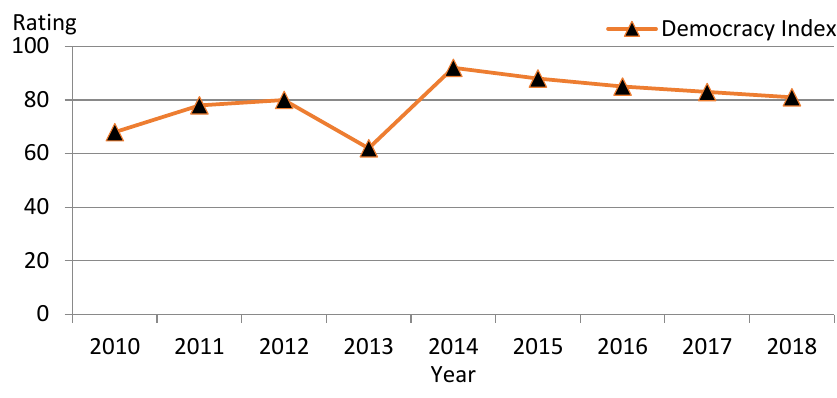
Fig. 3: The Democracy Index of Ukraine ( Democracy Index,